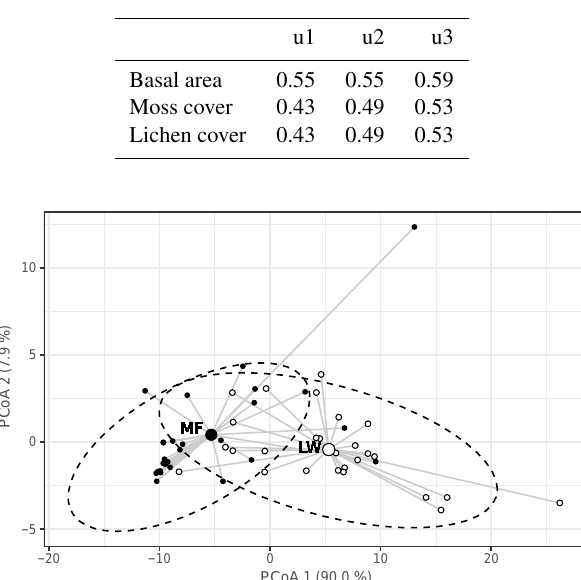
Table 4. Intragroup community indexes of vegetation variables relative to orthogonal canonical components of soil physico- geochemical variables.